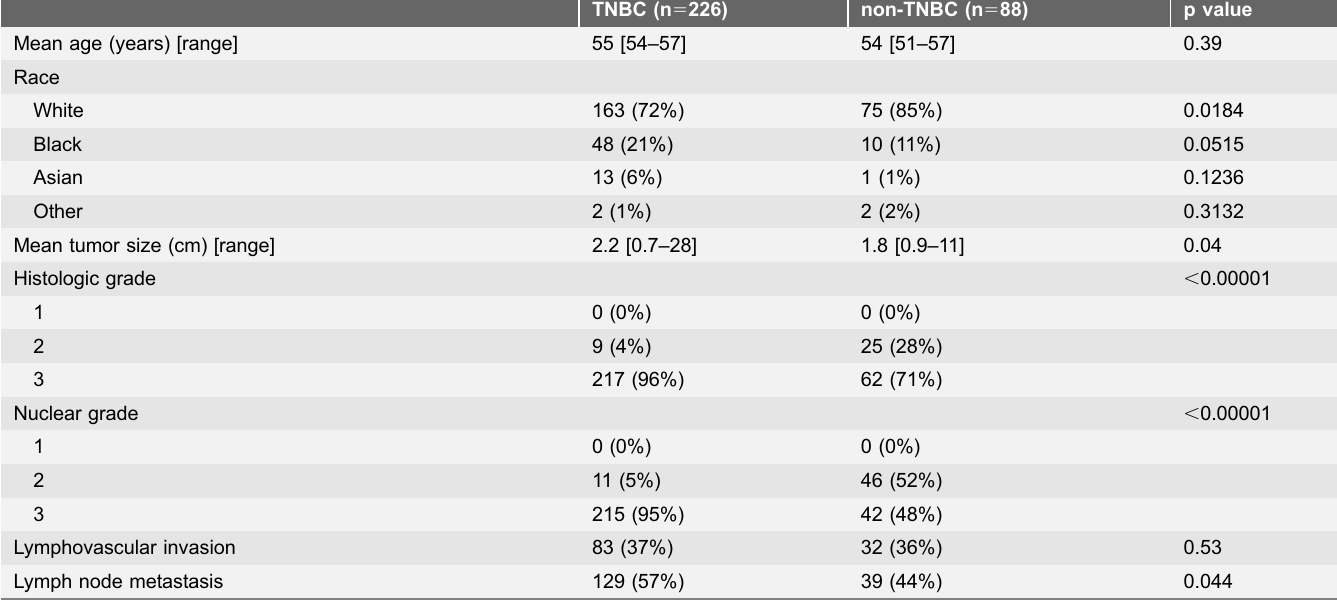
Table 1. Clinicopathologic Features of TNBC versus